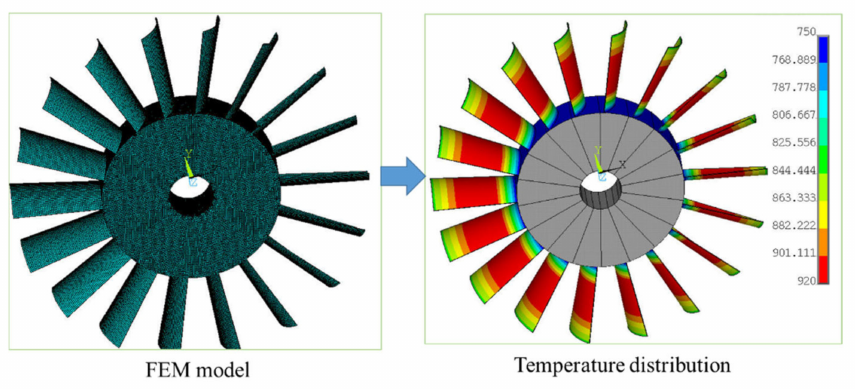
Figure 7. Temperature distribution on the blade obtained from FEM.